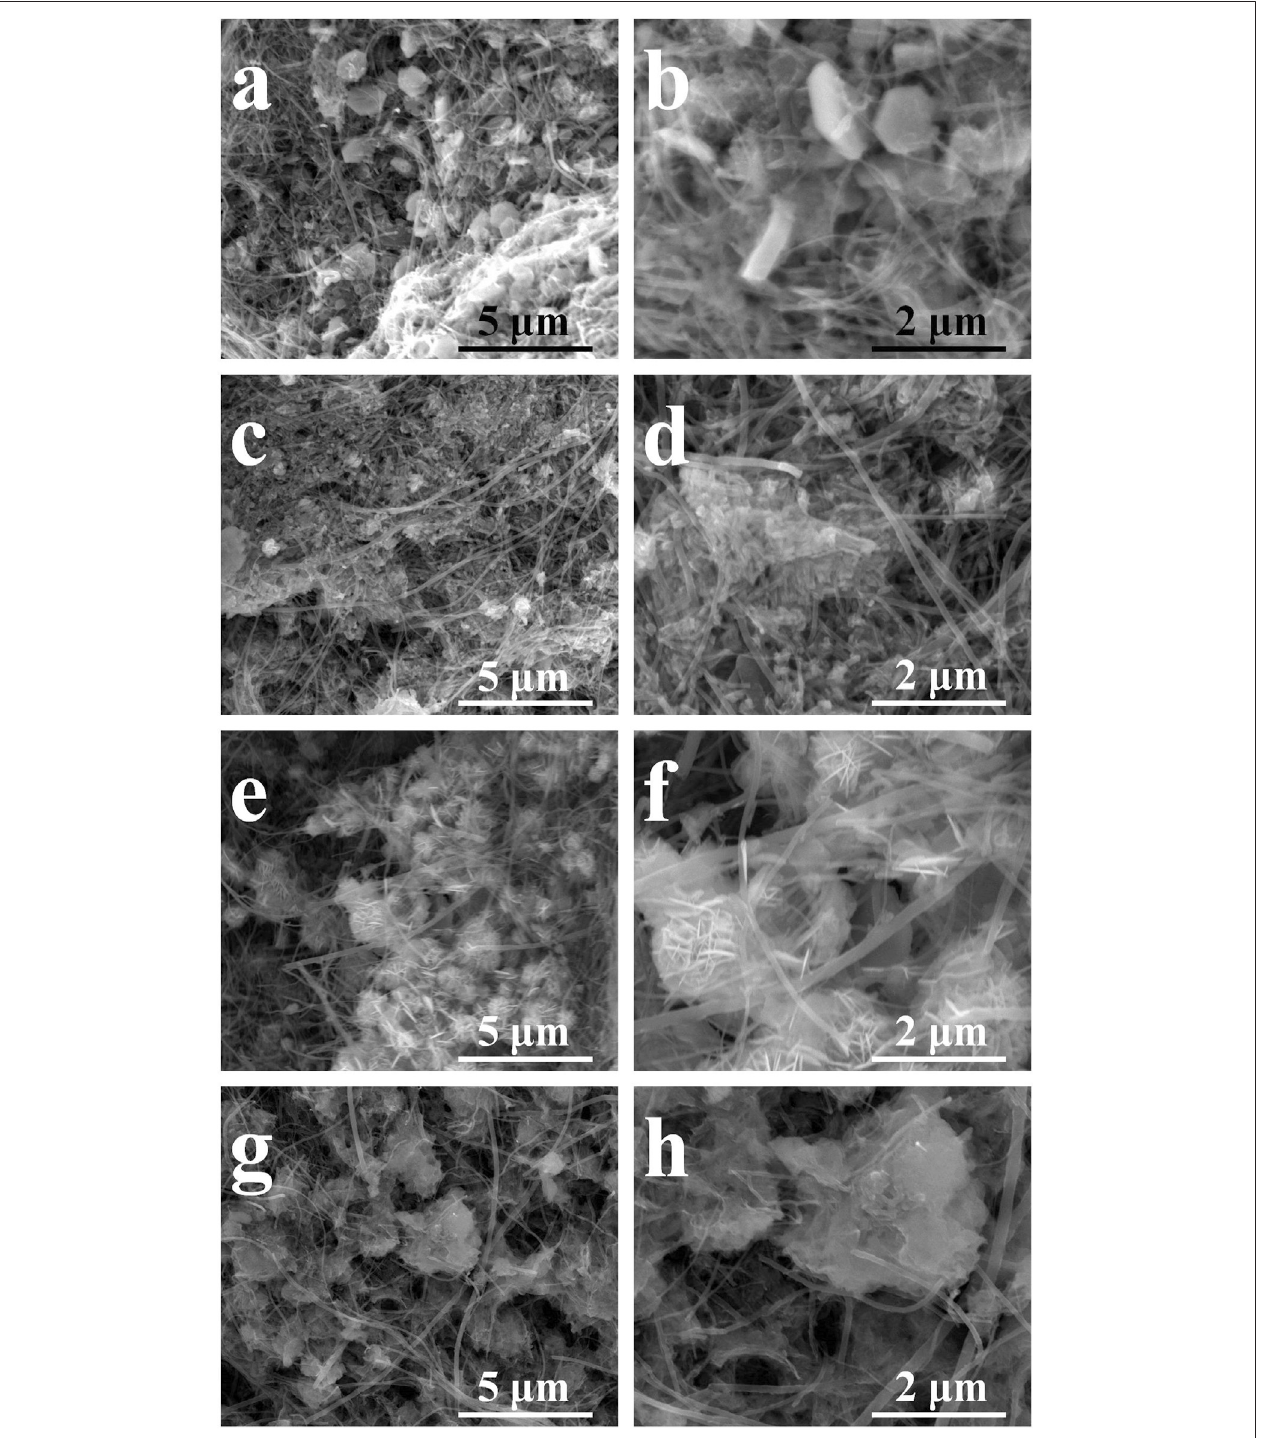
FIGURE6| TheSEMmorphologiesofconvertedCo/Nihydroxide/CNTpapercompositeelectrodeswithdifferentCo/Niratios:Co (A,B) ;Co2Ni (C,D) ;CoNi (E,F) ; CoNi2 (G,H) .